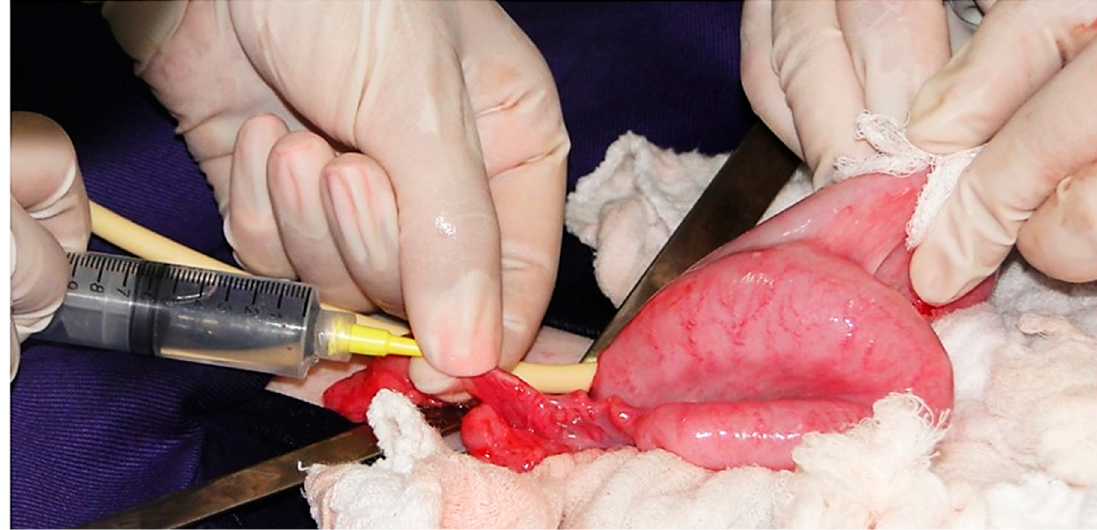
Figure 4. Uterine flushing for embryo collection in marsh deer ( B. dichotomus